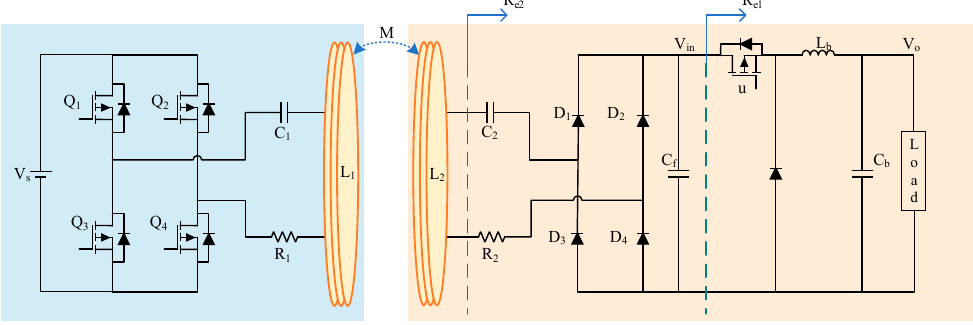
Figure 1. Structure of series–series compensated WPT system.